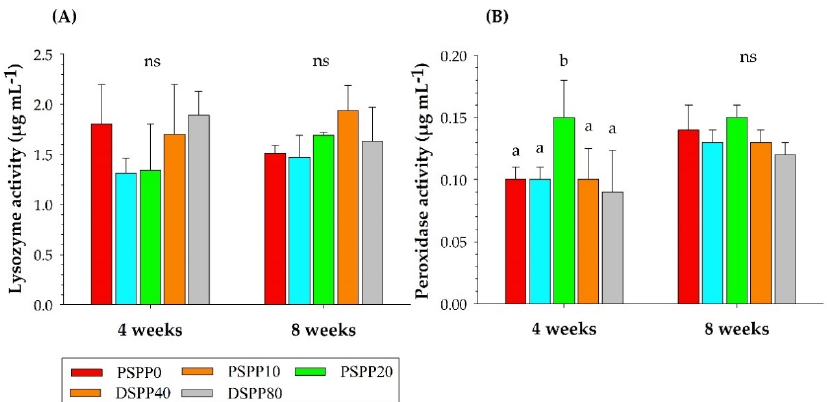
Figure 1. Lysozyme ( A ) and peroxidase ( B ) activity in the skin mucus of Nile tilapia after four and eight weeks of feeding with experimental diets: 0 g kg − 1 (PSPP0) control, 10 g kg − 1 (PSPP10), 20 g kg − 1 (PSPP20), 40 g kg − 1 (PSPP40), and 80 g kg − 1 (PSPP80) cultivated for eight weeks. Data are presented as mean ± SE. Significantly different levels are denoted by superscript letters ( p < 0.05). “ns” denotes no significant difference.